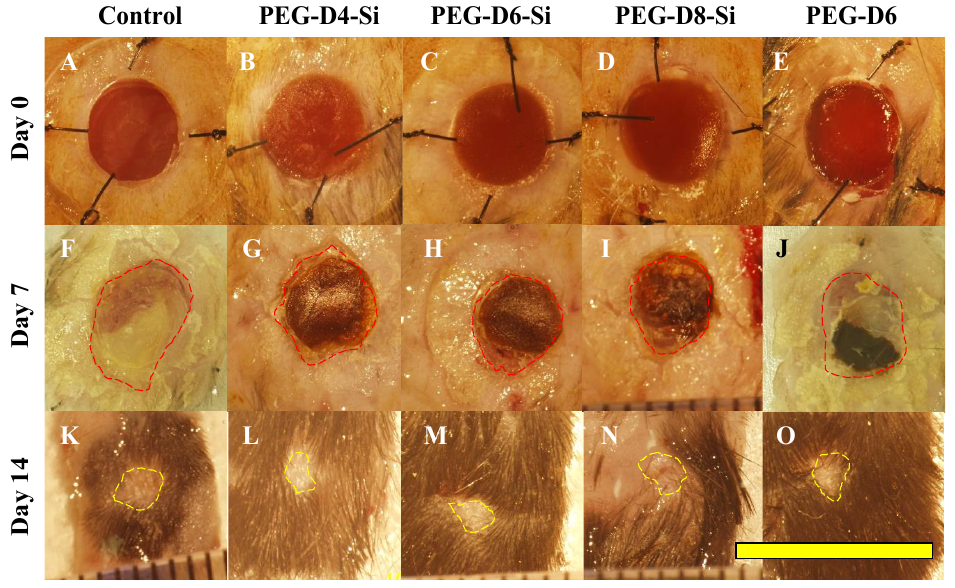
Figure 5. Representative images of the wounds at day 0 (top), 7 (middle), and 14 (bottom) of control ( A , F , K ), PEG-D4-Si ( B , G , L ), PEG-D6-Si ( C , H , M ), PEG-D8-Si ( D , I , N ), and PEG-D6i ( E , J , O ). Red and yellow dash line indicates the wound area. Scale bar = 1 cm.